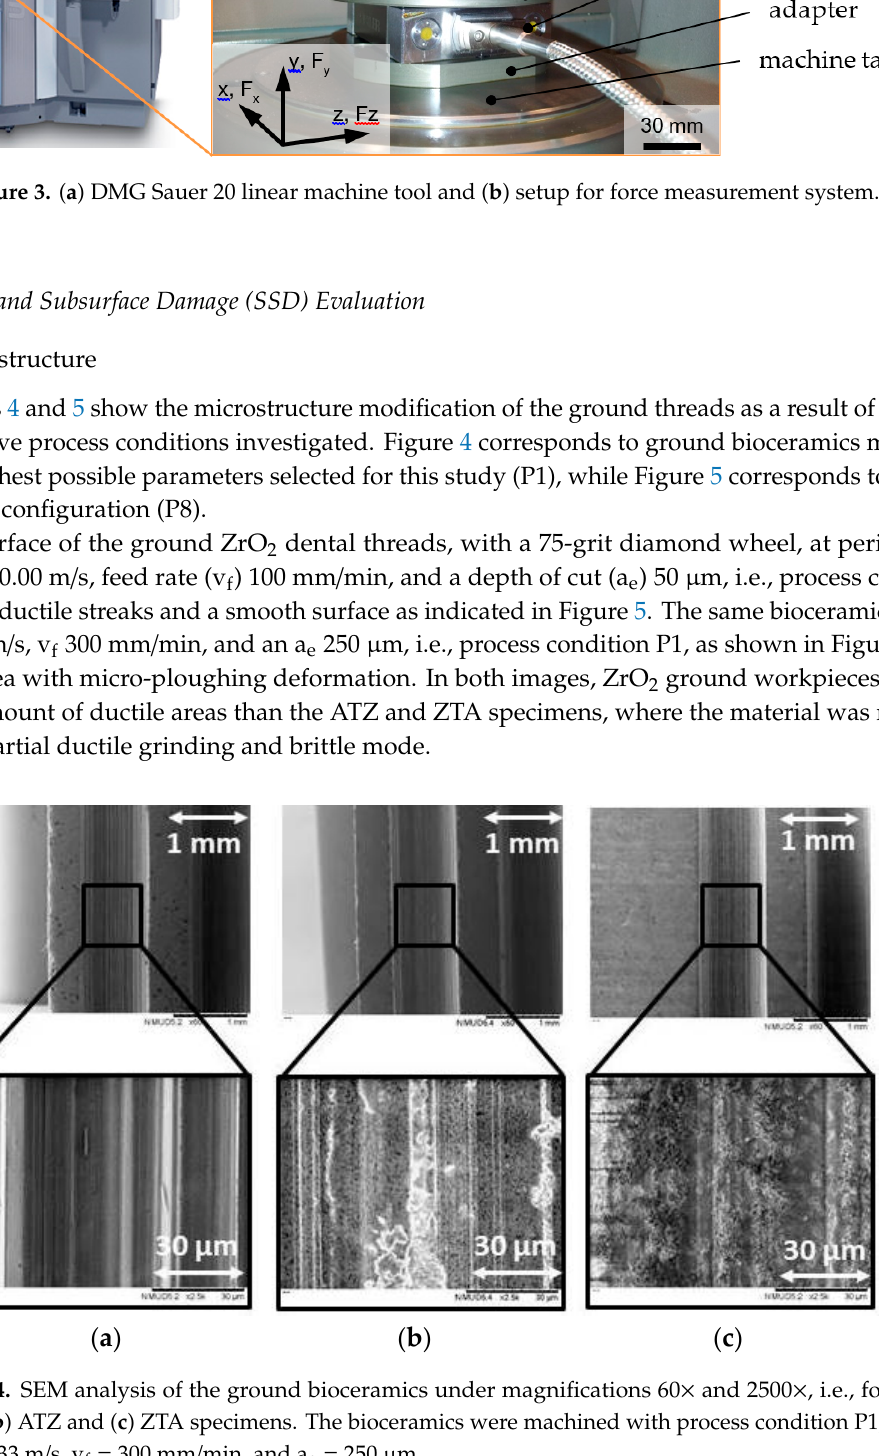
Figure 3. ( a ) DMG Sauer 20 linear machine tool and ( b ) setup for force measurement system.